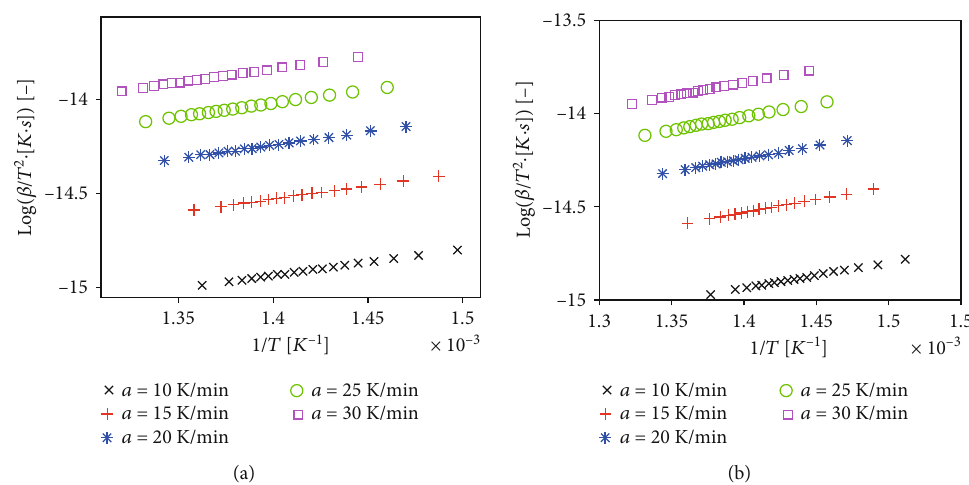
Figure 3: Arrhenius plot obtained using conversion rate intervals of 5% for the PET (a) and recycled PET (b)